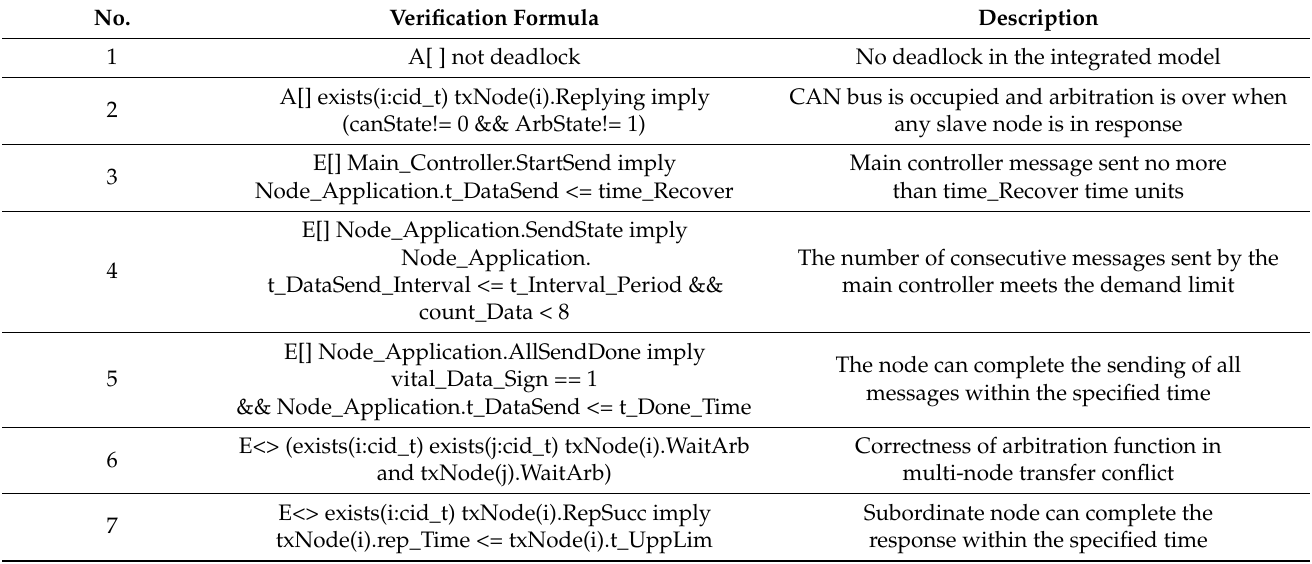
Table 3. Property verification formula and its description.